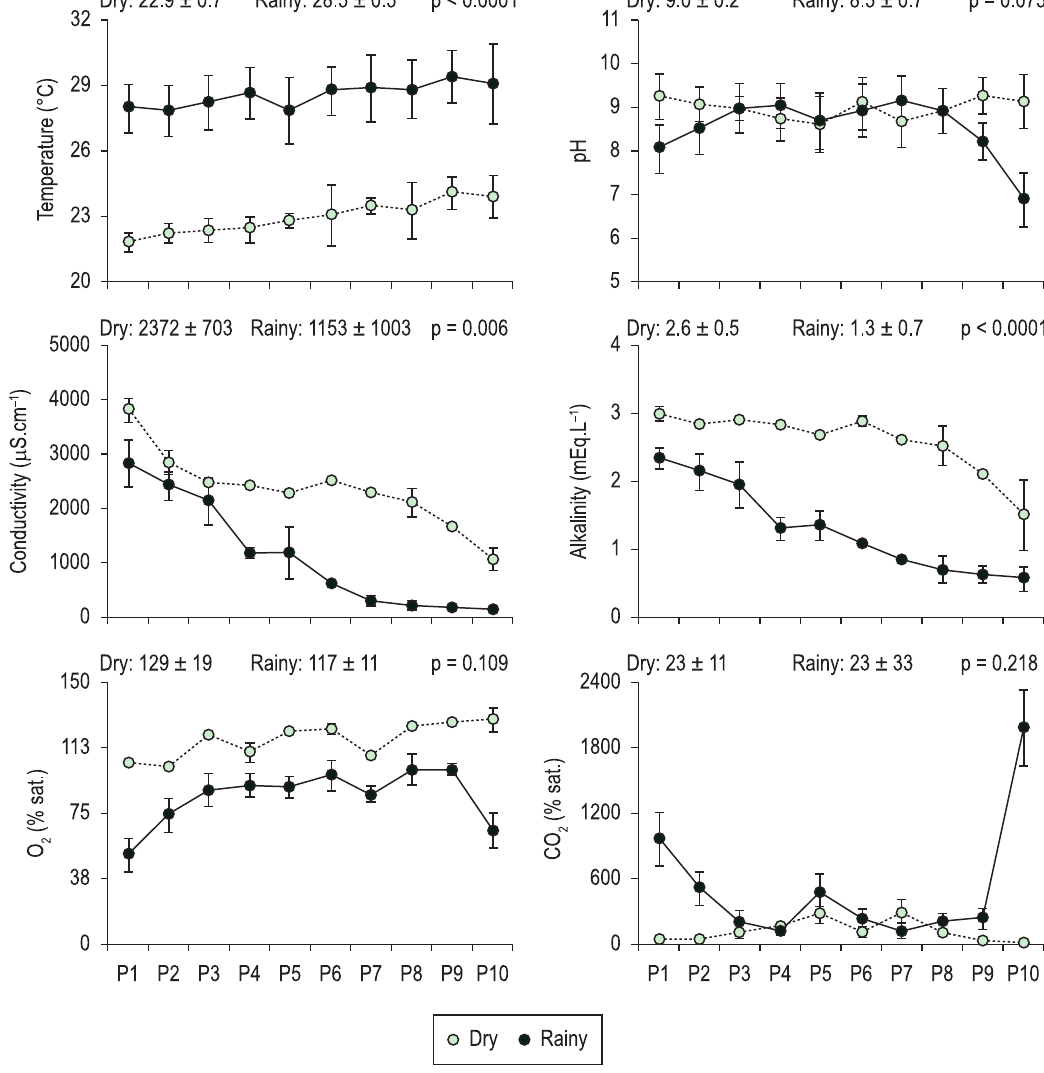
Figure 2. Temperature, electrical conductivity, alkalinity, pH, O and rainy (January/2002) season. The vertical bars represent the standard deviation. Mean ± standard deviation values for each season and significance